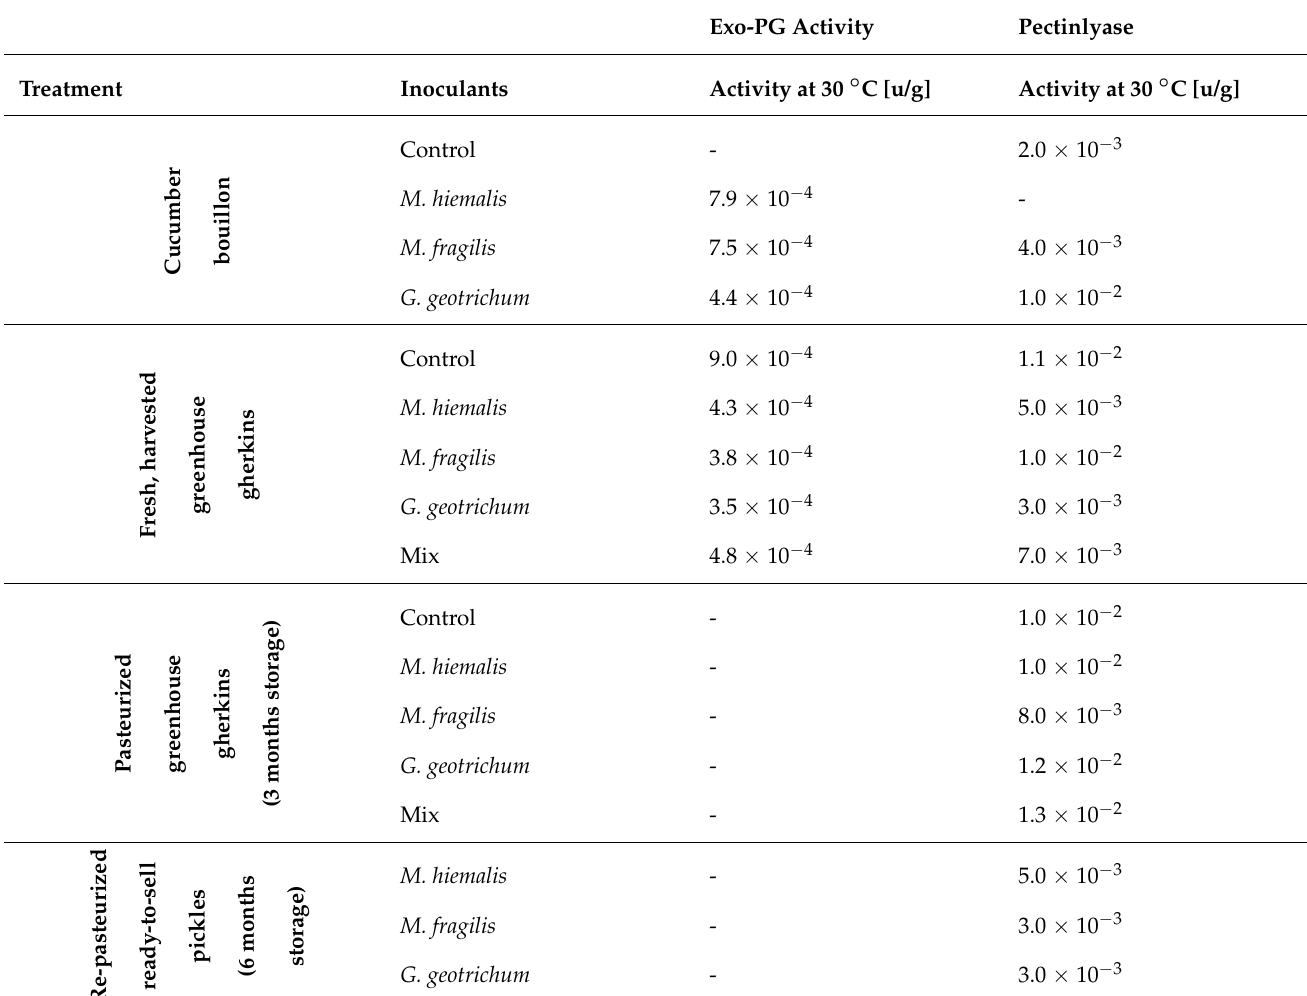
Table A2. Exo-Polygalacturonase and pectinlyase activity at different processing stages of fungal- inoculated gherkins at pH 5.5 and a temperature at 30 ◦ C. The fungi Galactomyces geotrichum , Mucor hiemalis , and Mucor fragilis were used for